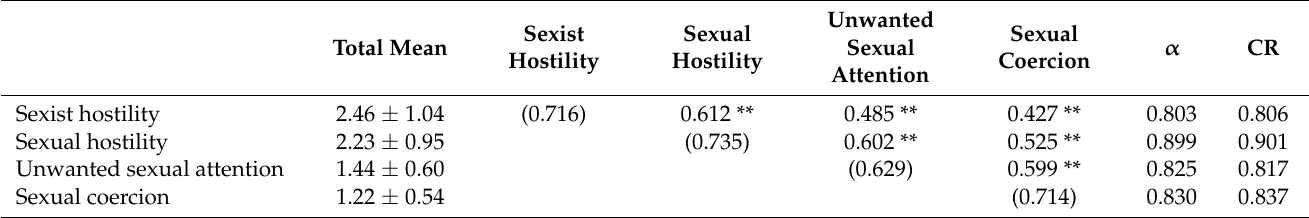
Table 2. Means, correlations between factors, and square roots of average variance extracted (In the diagonal); Cronbach’s Alpha; composite